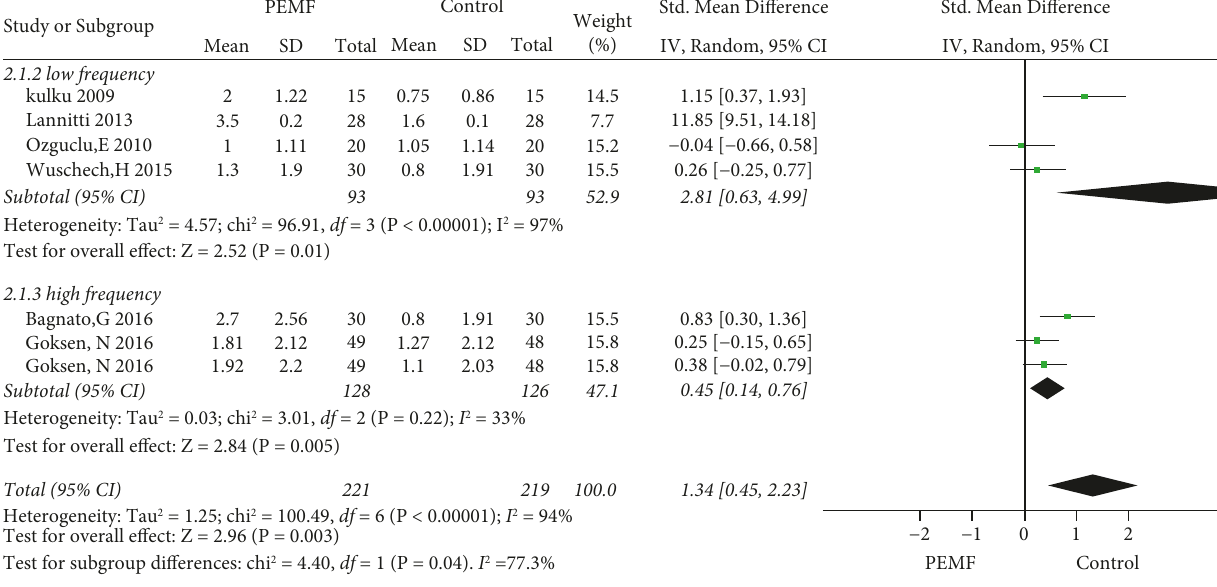
Figure 7: Forest plots represent the effect of PEMF versus control therapies in stiffness and subgroup analysis basing on various frequency.